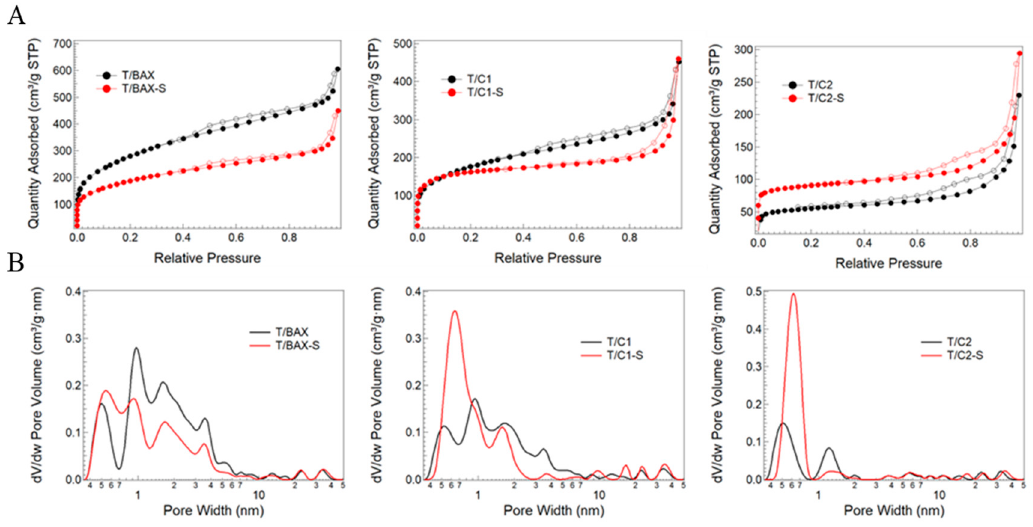
Figure 3. ( A ) Nitrogen adsorption isotherms; ( B ) Pore size distributions.